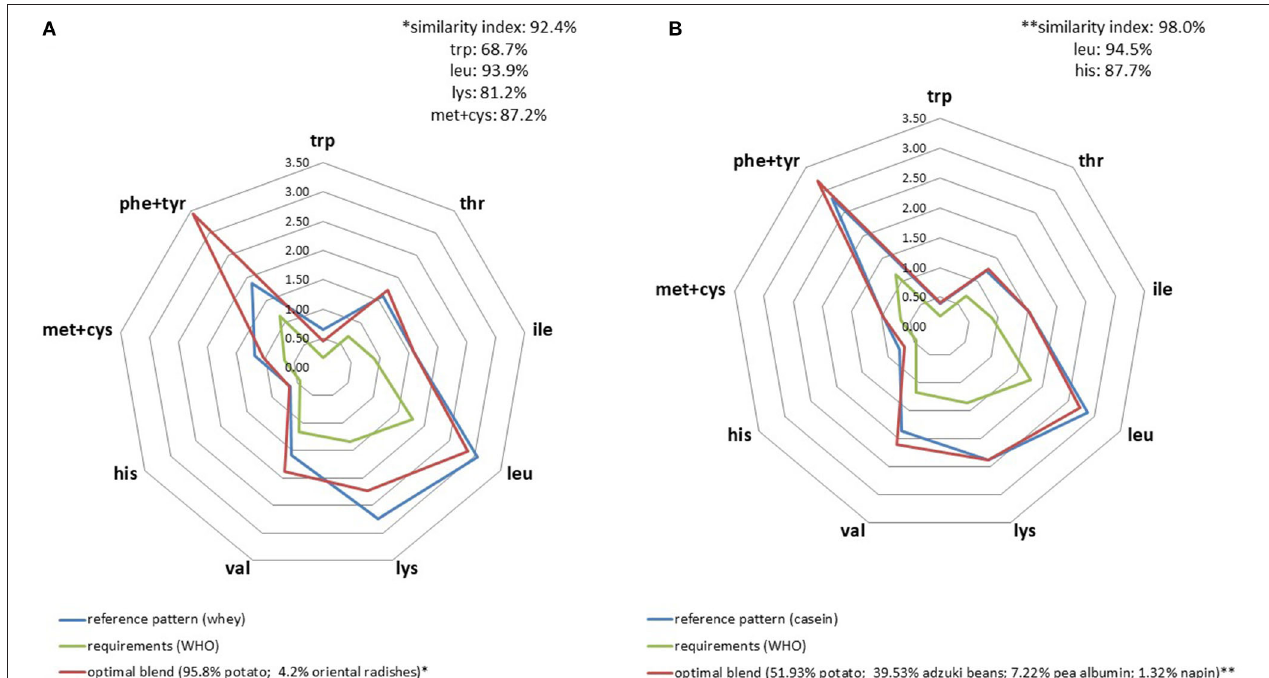
FIGURE 3 | IAA profiles (g/30g) of optimal plant blends that best replicated whey (A) and cow milk casein (B) IAA profiles.